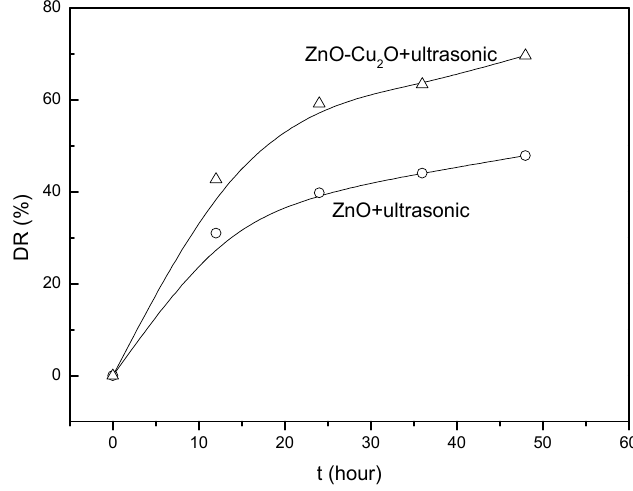
Figure 7. The decolorization of MB using ultrasonic irradiation.